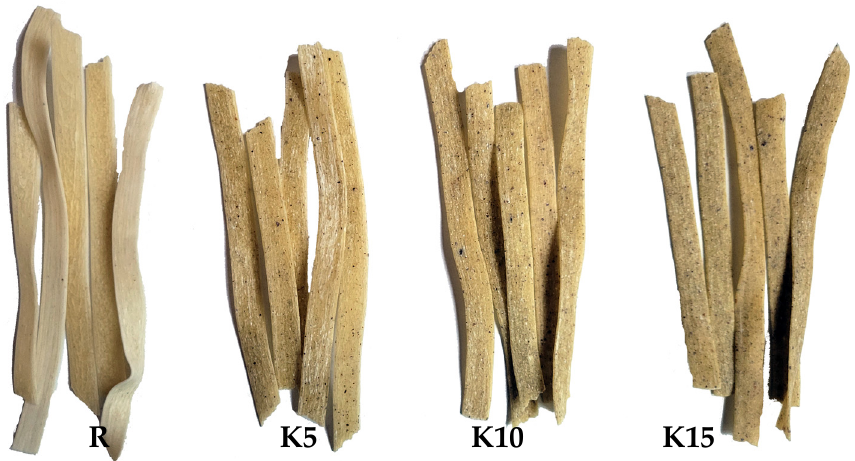
Figure 1. The overall appearance of obtained pasta. R—reference pasta without the addition of kiwiberry lyophilizate; K5, K10, and K15—pasta contained 5%, 10%, and 15% kiwiberry lyophilizate.